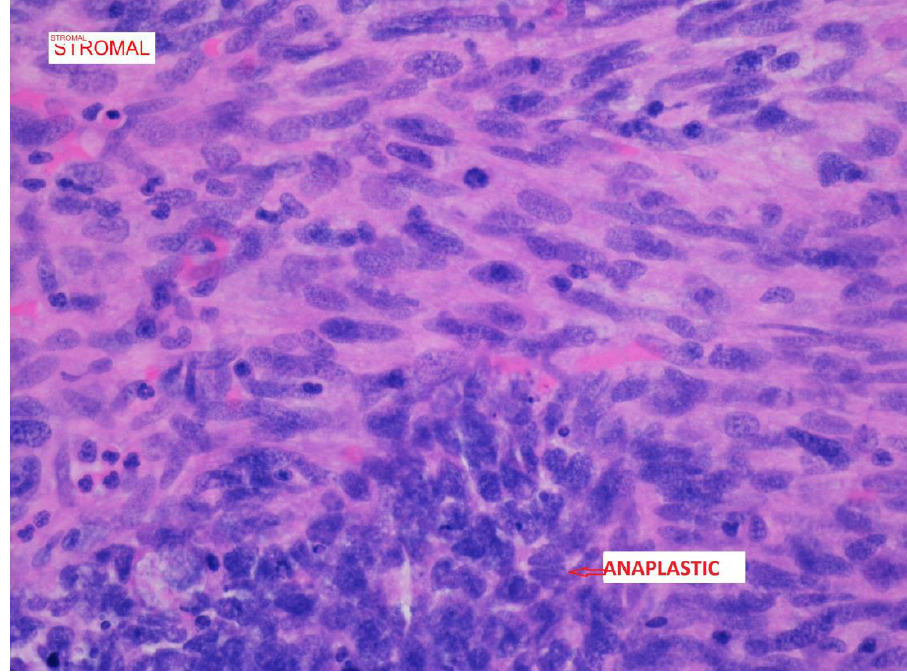
Figure 5. Microscopic features of adult Wilms’ tumour showing stromal elements and focal anaplastic